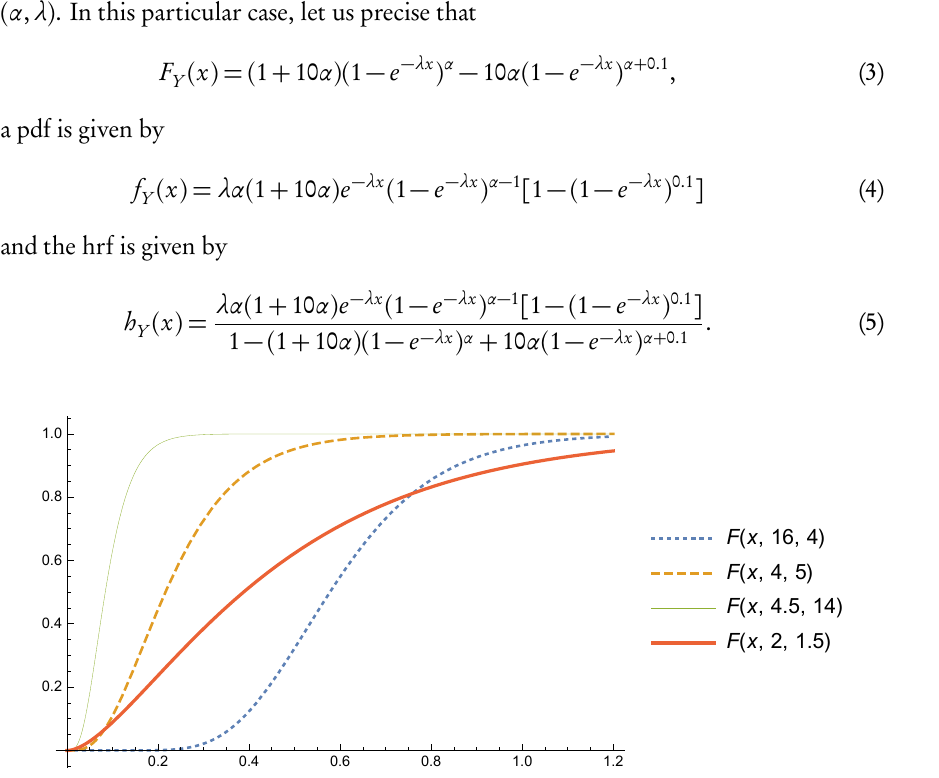
Figure 1 – Some cdfs F ( x ) = F ( x ; ( α , λ )) (3) with various values for α and λ